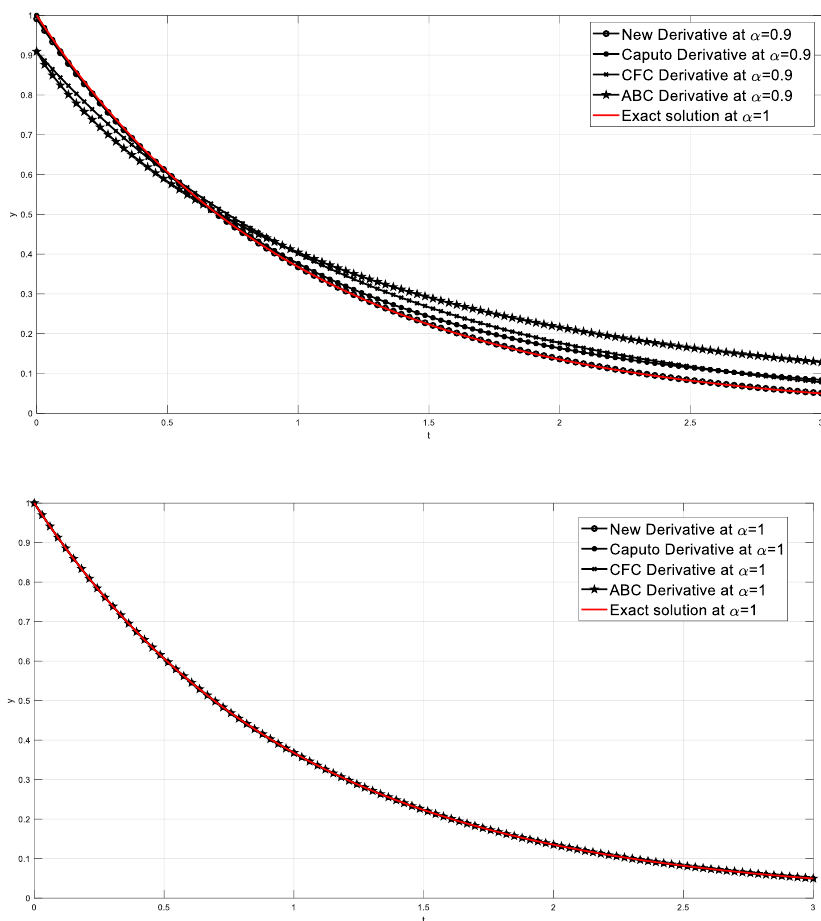
Mathematics 2022 , 10 , x FOR PEER REVIEW 3 of 18